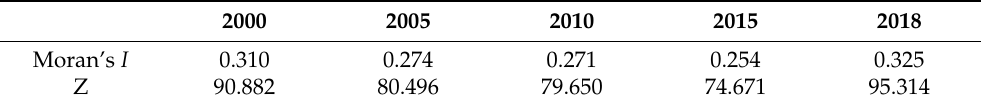
Table 3. Global Moran’s I from 2000 to 2018.